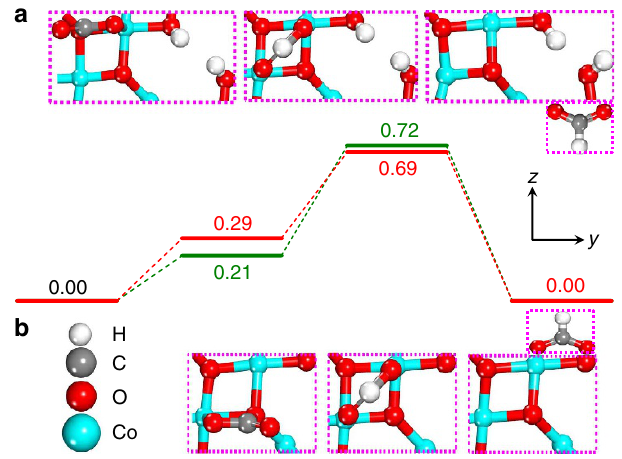
Figure 5 | Calculated free energy diagrams. Calculated free energy diagrams for the electrochemical reduction of CO 2 to formate on the Co 3 O 4 single-unit-cell layers with oxygen vacancies ( a ) and the intact Co 3 O 4 single-unit-cell layers ( b ), respectively; energy unit in eV. The first step is an electron transfer step to form CO (cid:3)(cid:2)(cid:4) and the second step includes a 2 simultaneous proton/electron transfer. The final state is HCOO (cid:2) in solvent (Solvent effect was not considered during the DFTcalculations.). Values of D G are reported with at the (cid:2) 0.225V versus NHE, which is the equilibrium potential of the whole reduction process. For the energy of electron is independent on pH value, so the free energy of electron is set as 0.225V versus NHE. Asterisk represents the active site; white, red, grey and light blue spheres represent H, O, C and Co atoms,